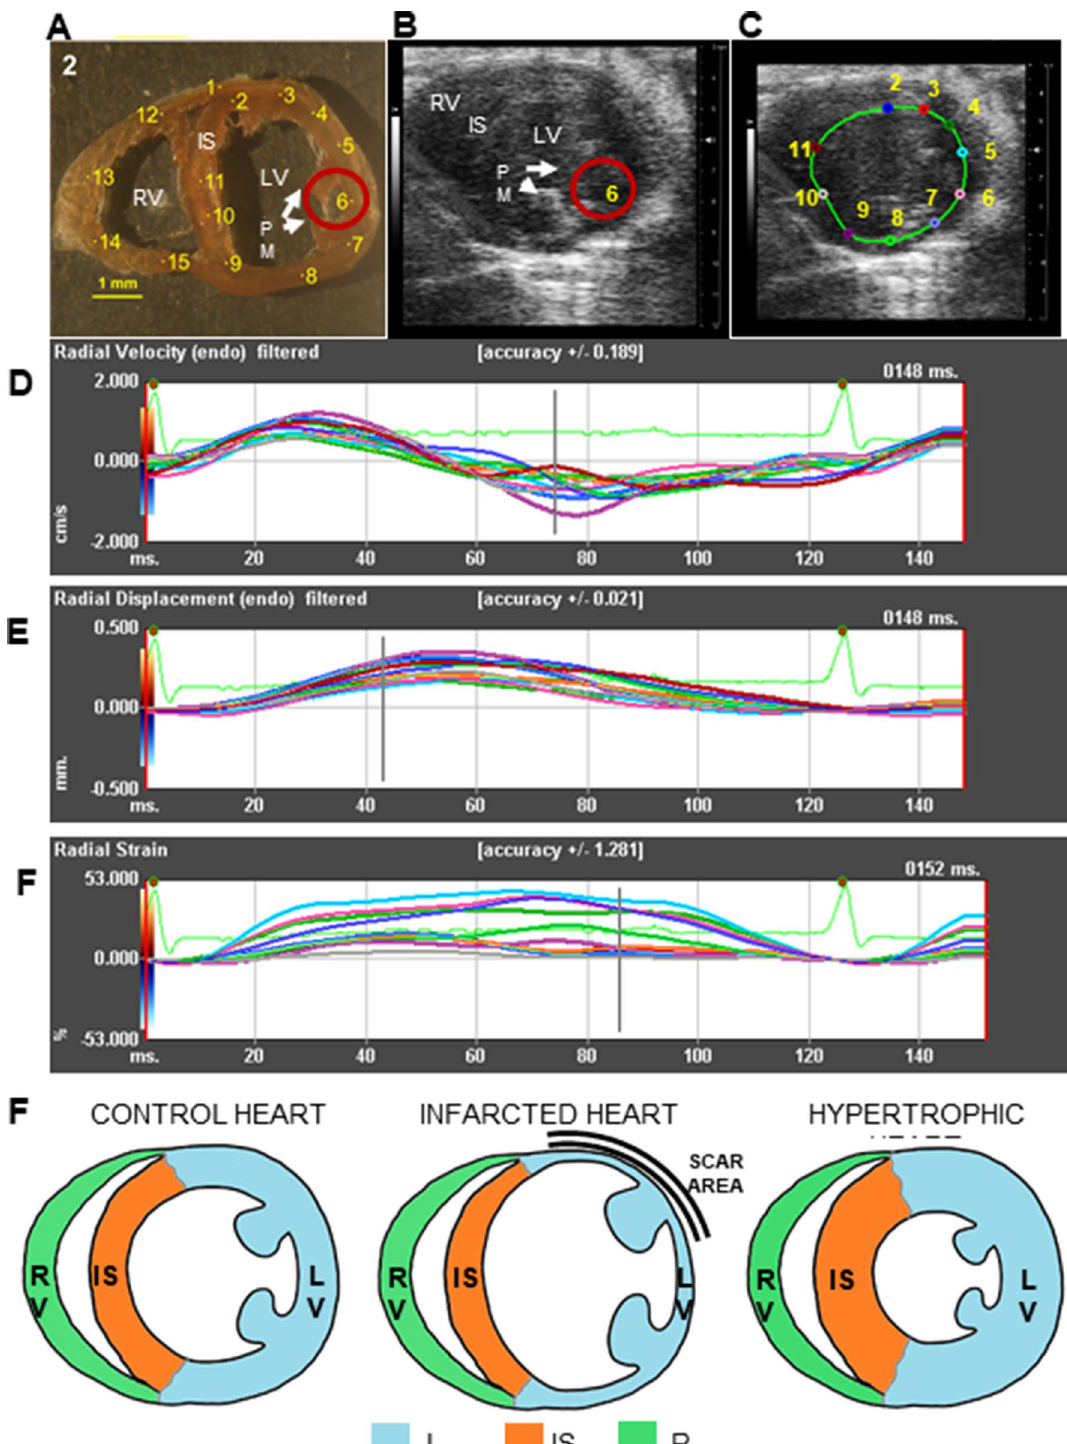
Figure 3. Speckle tracking echocardiography and corresponding segments. ( A ) Myocardial points analysed by mBS in a representative control heart. ( B , C ) Short axis echocardiography image ( B ) with the selected points to be tracked ( C ). ( D–F ) Representative radial velocity ( D ), radial displacement ( E ) and radial strain ( F ) measured along time for each selected point. ( G ) Heart segments analysed in the study. RV right ventricle, IS interventricular septum, LV left ventricle, ms